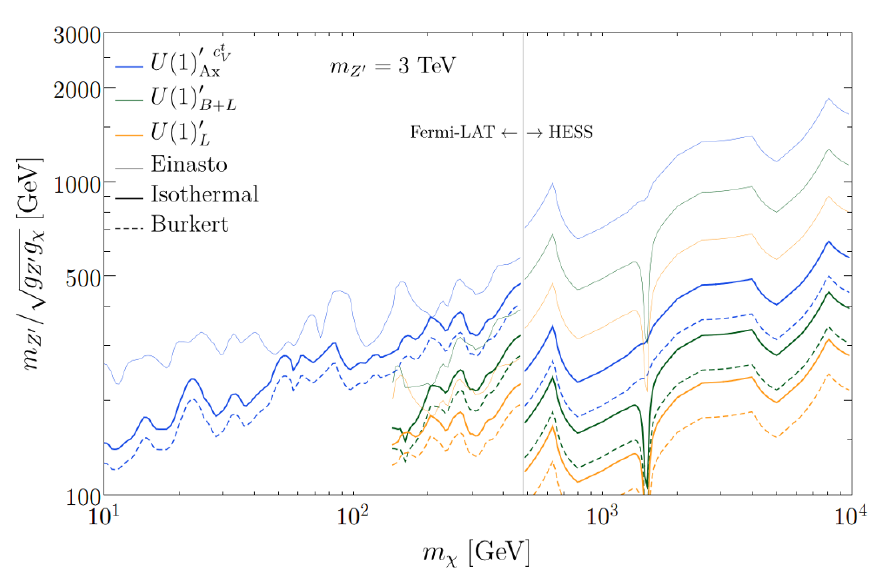
Figure 6 . Limits from Fermi-LAT [59] and HESS [60] searches for (cid:13) ray lines. Below (above) DM masses of 500 GeV, Fermi-LAT (HESS) provides the constraint. The choice of mediator mass a(cid:11)ects only the resonance region m (cid:31) m Z 0 = (cid:25)